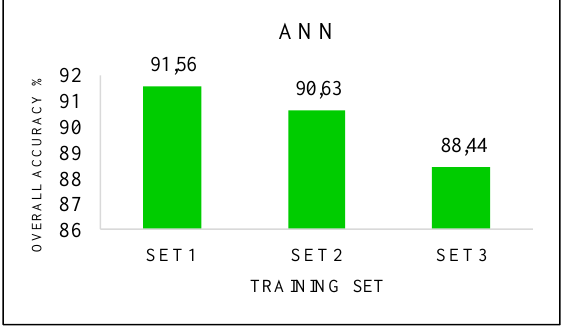
Figure 3. ANN classification and training set